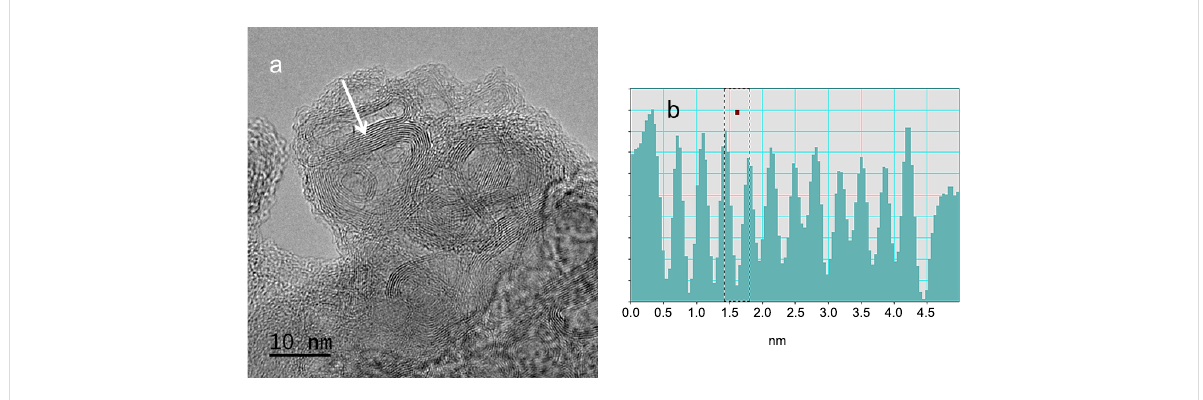
Figure 3: a) HRTEM image of C-onions obtained by carbonization in NaOH 30% (w/v), using tomatoes as carbon source; b) intensity profile (arbi- trary units) measured over the white arrow marked in a).